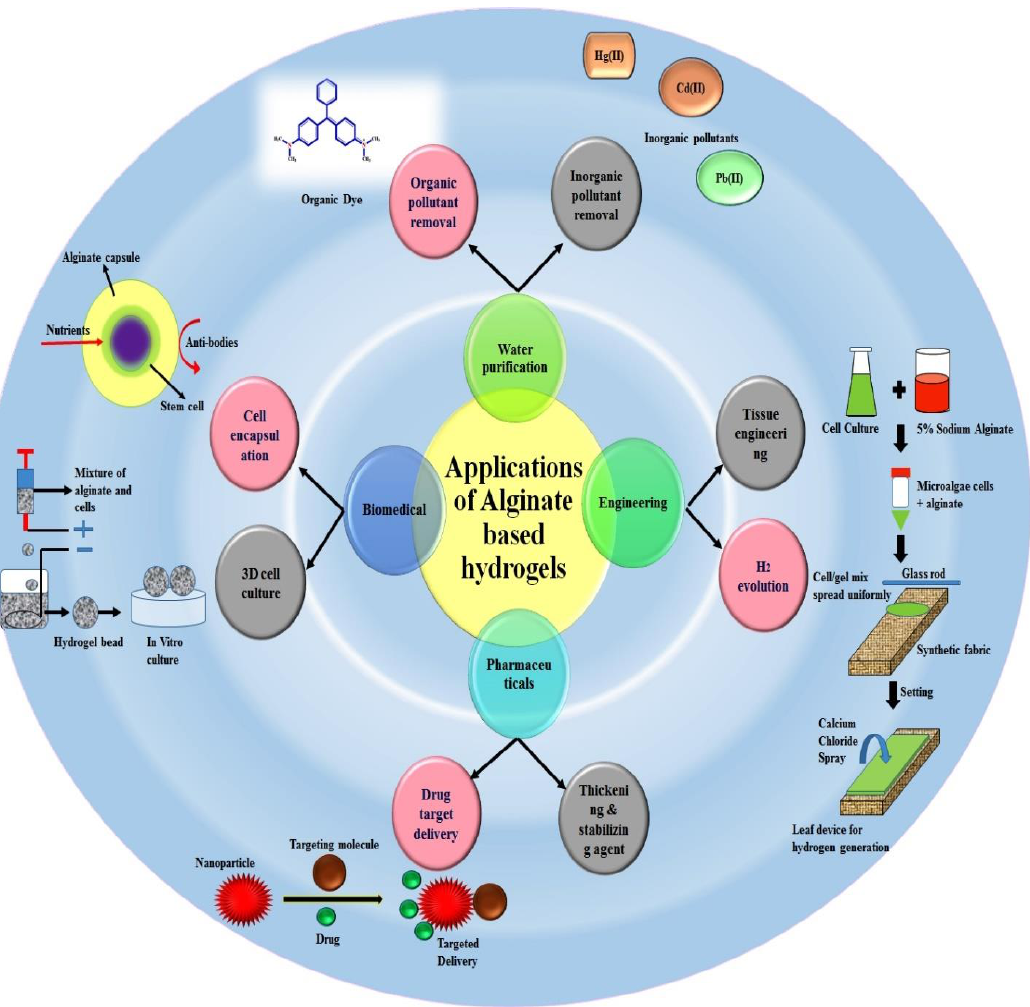
Figure 7. Various applied applications of alginate based hydrogels [135]. Reprinted with permission from Ref. [135]. Copyright Elsevier, 2018.